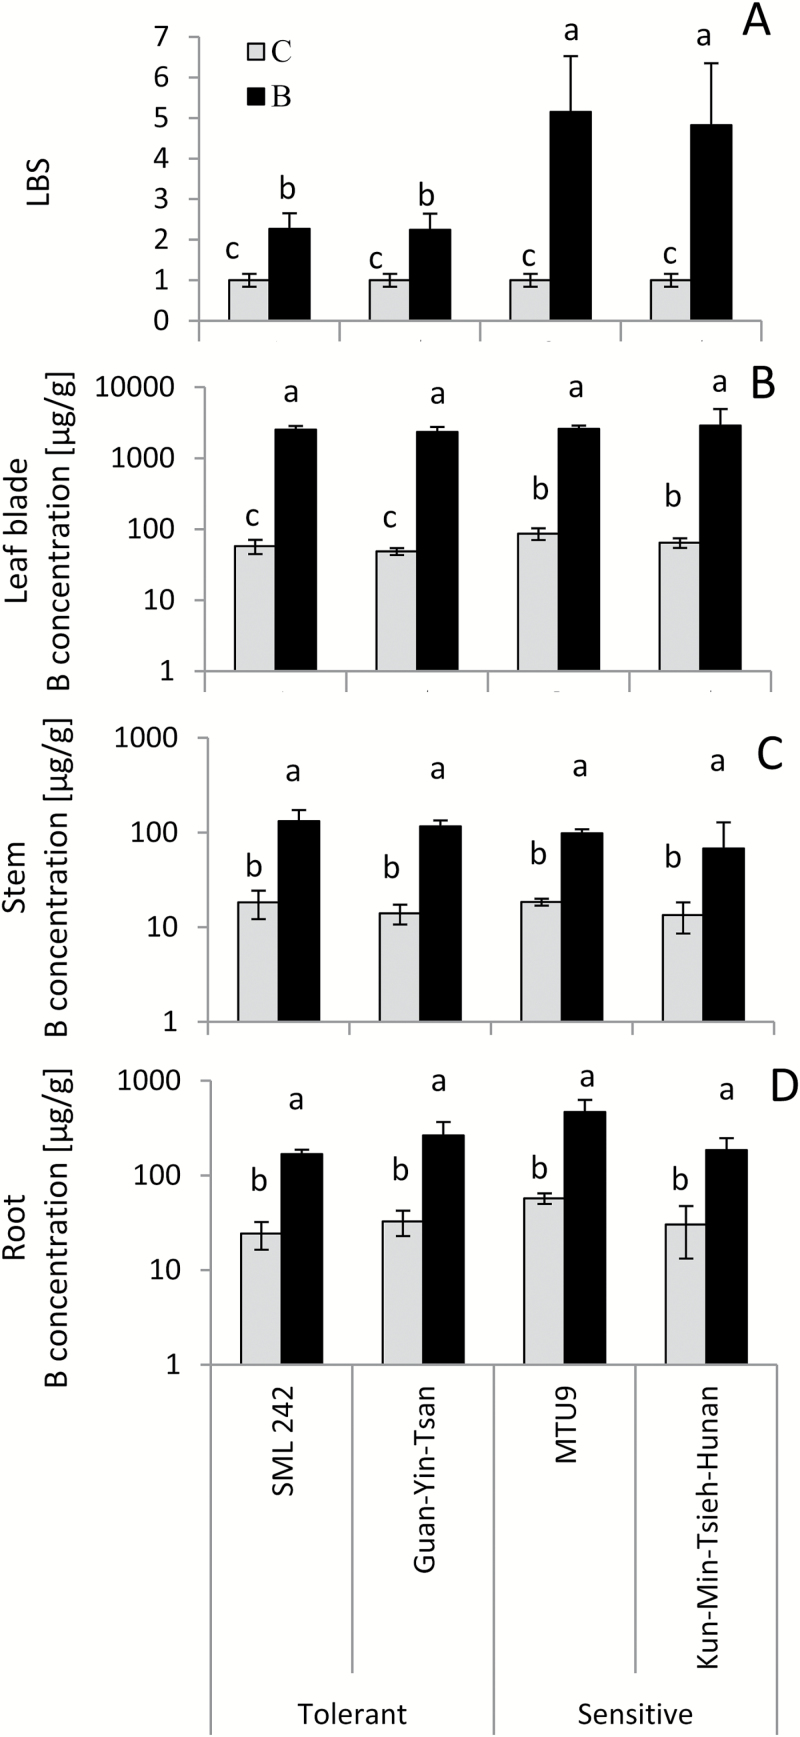
Phenotypic responses of four contrasting rice varieties to B stress. Data are from experiment Btox3, where seedlings of four rice varieties (B-tolerant SML242 and Guan-Yin-Tsan; B-sensitive MTU9 and Kun-Min-Tsieh-Hunan) were subjected to control conditions (C, gray bars) and +2 mM B (B, black bars). (A) Leaf bronzing score (LBS); (B) B concentration in leaf blades; (C) B concentrations in stem and leaf sheaths; (D) B concentration in roots. Data bars show mean values and SEs; bars not sharing the same letter in the same variety are significantly different at P<0.05 by Student’s t-test.